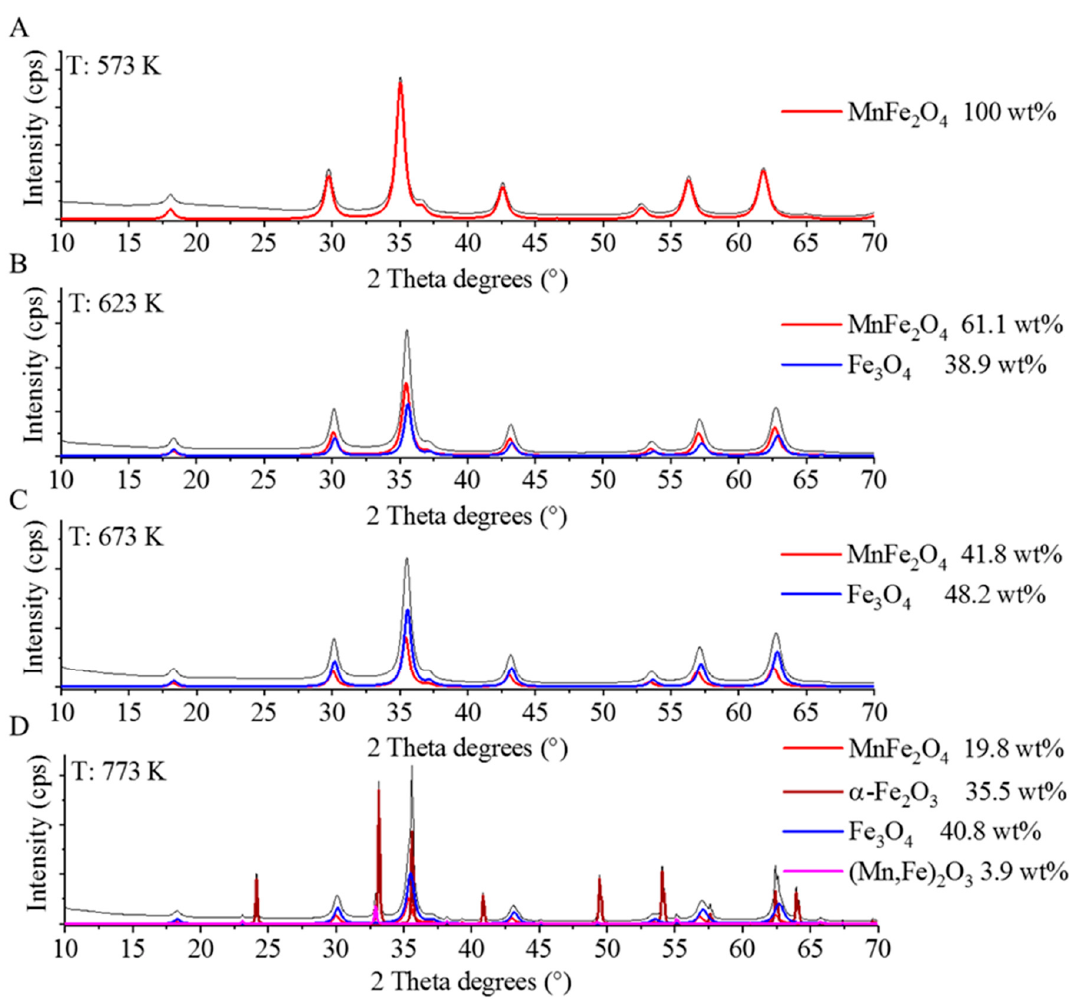
Figure 1. X-ray diffractograms of the ferrite samples produced at 573 K ( A ), 623 K ( B ), 673 K ( C ) and 773 K ( D ) temperatures.